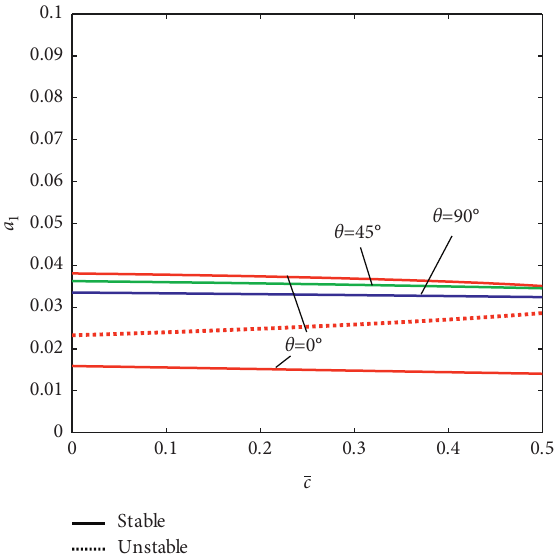
Figure 11: Amplitude versus damping coefficient with different detuning parameter values (L/d � 10, c � 0.01, θ � 0 ° , case I).